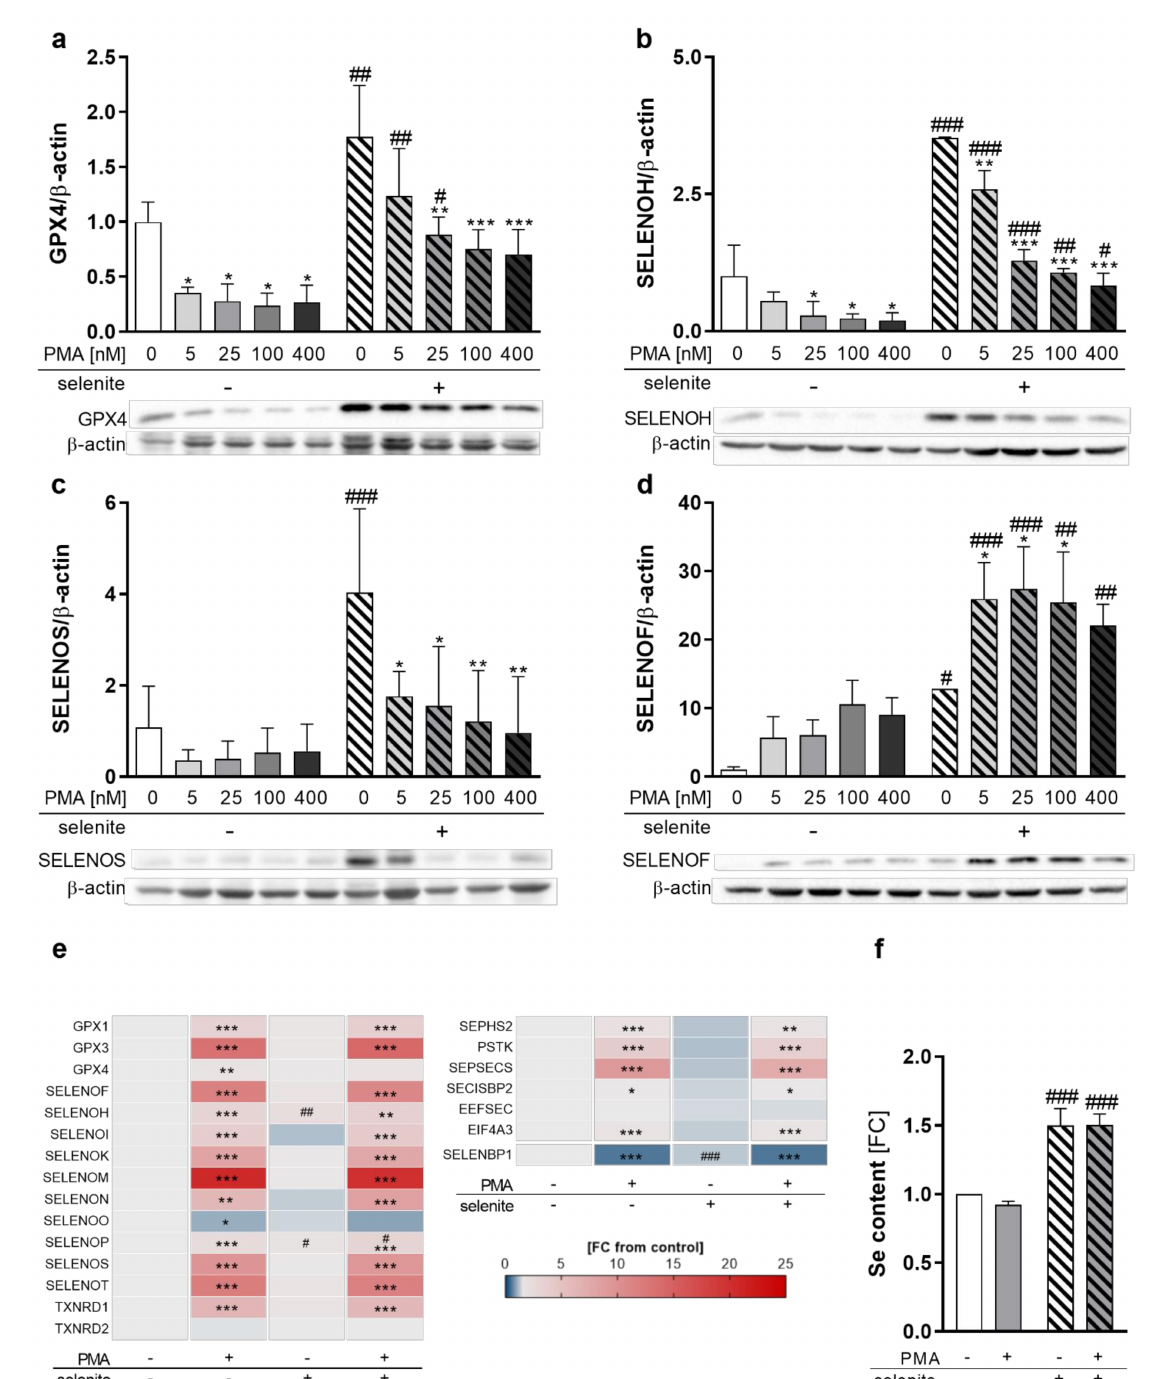
Figure 2. Expression of selenoproteins as well as proteins involved in selenoprotein biosynthesis during differentiation. THP-1 monocytes were pre-treated for 72 h with or without 50 nM sodium selenite (selenite) and differentiated into macrophages using 5–400 nM PMA ( a – d ) or 25 nM PMA ( e , f ) with or without 50 nM sodium selenite treatment for 48 h. ( a – d ) Protein expressions of GPX4 ( a ), SELENOH ( b ), SELENOS ( c ), and SELENOF ( d ) were normalized to β -actin. -PMA/- selenite samples were set to 1. Representative blots are shown. ( e ) Heatmap of mRNA expression of different selenoproteins and proteins involved in the biosynthesis of selenoproteins analyzed by qRT-PCR. The color scale indicates the mean difference as fold change (FC) of target genes vs. -PMA/-selenite (FC = 1). ( f ) Se content of the cells. -PMA/-selenite samples were set to 1. Data are given as means + SD (n = 3–4). Two-way ANOVA with Bonferroni’s post-test. Significant outliers were determined by Grubbs ´ test ( α = 0.05). * p < 0.05, ** p < 0.01, *** p < 0.001 vs. cells without PMA (PMA effect); # p < 0.05, ## p < 0.01, ### p < 0.001 vs. cells without selenite (Se